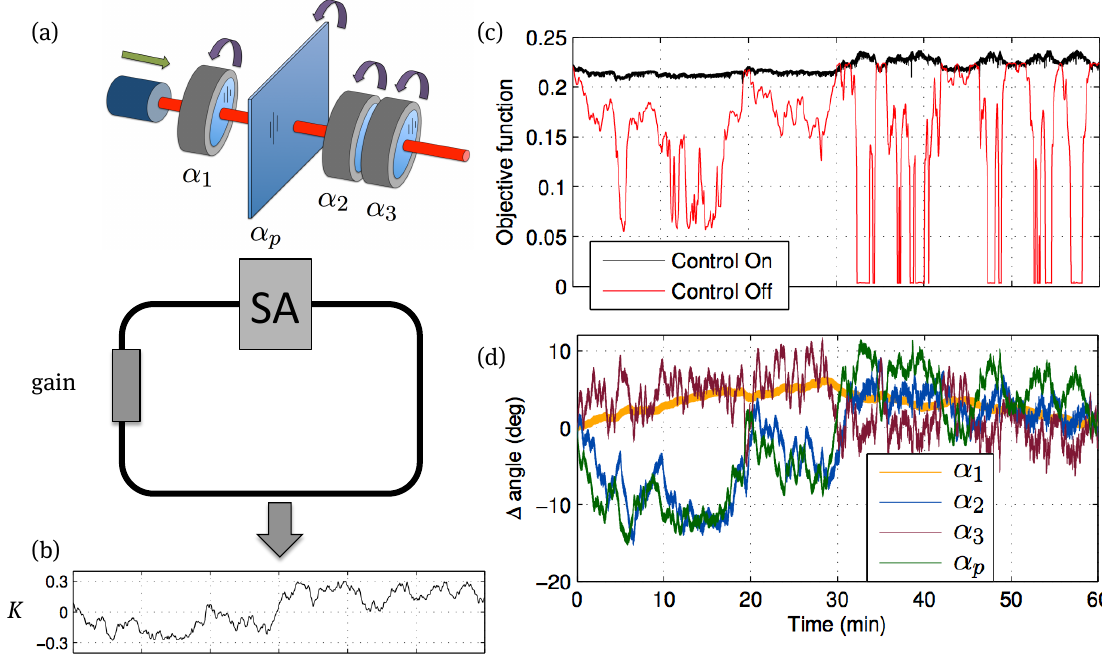
Figure 7: (a) Demonstration of the performance of extremum-seeking controller on a mode-locked laser cavity with saturable absorp- tion (SA) achieved with the waveplates and polarizer. (b) Note the significant variance in the birefringence parameter over the time span t ∈ [0, 60] (in minutes). (c) Without control, the objective function crashes several times, resulting in failure to mode-lock. With control, the system remains at a high-performance mode-locked state for the entire trial. (d) The variation of the waveplates and polarizer to track changes in the birefringence are also shown, demonstrating the equation-free control protocol of ESC.